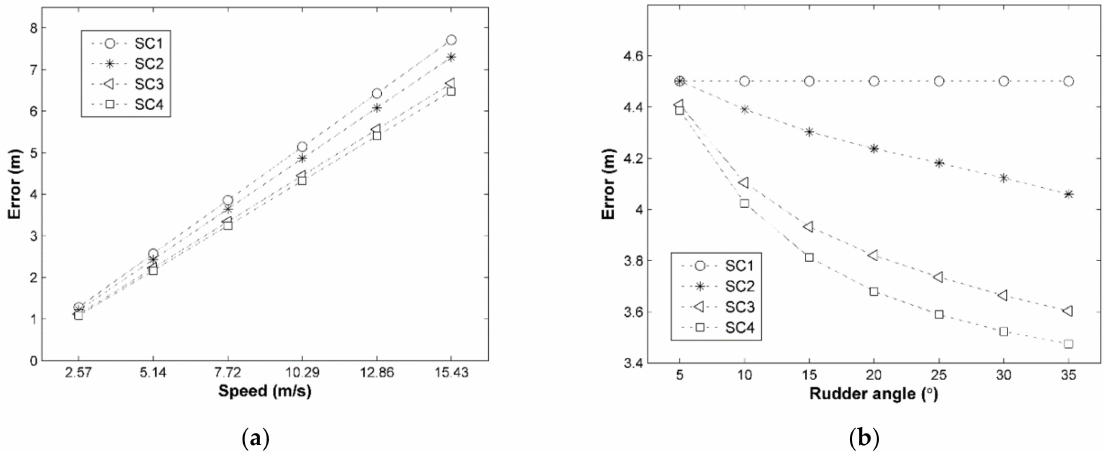
Figure 10. Estimation error of critical latency for each of six vessel speeds and seven rudder angles: ( a ) error for six vessel speeds in four scenarios; ( b ) error for seven rudder angles in four scenarios.